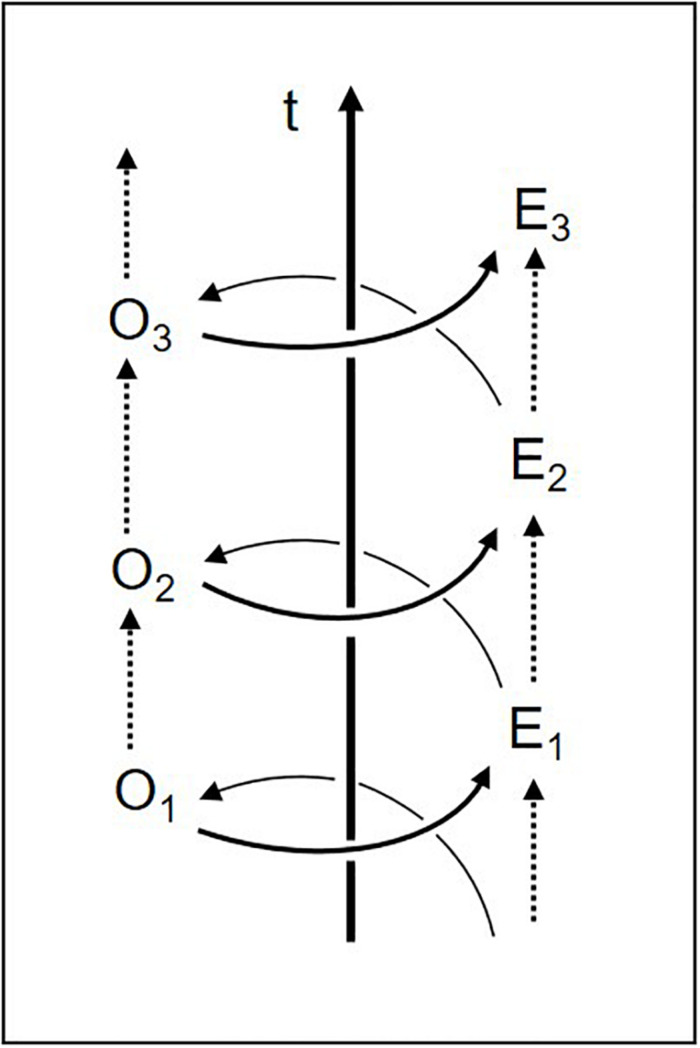
Co-evolution of organism (O) and environment (E) over time (t) (adapted from Fuchs, 2018, p. 103).